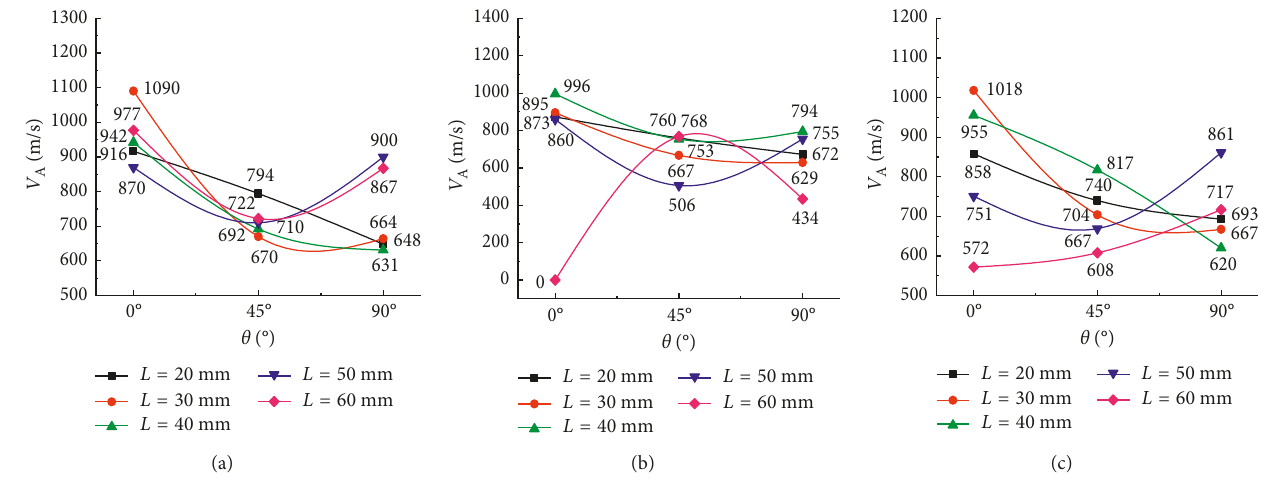
Figure 24: Relationship between θ and V